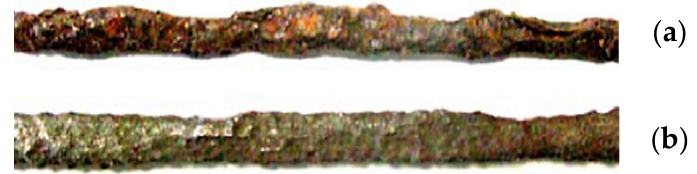
Figure 1. Comparison between: ( a ) natural and ( b ) artificial corrosion.